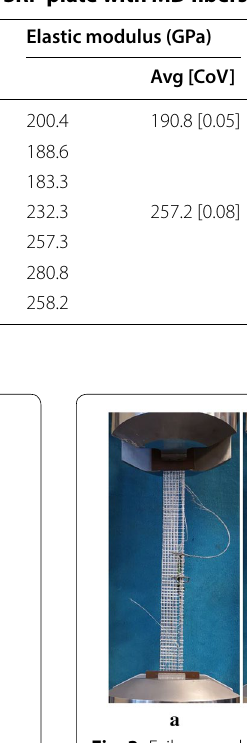
Fig. 3 Failure mode of: a bare steel fiber sheet, and b SRP plate with MD